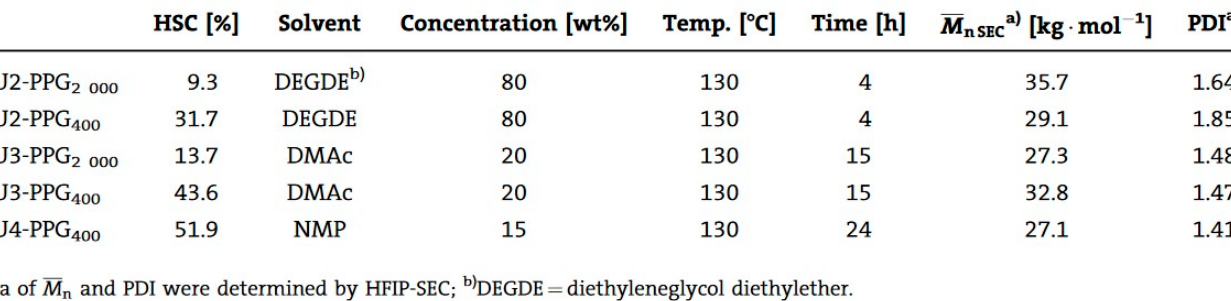
Figure 37. Table copied from reference [60]. Results of polymerizations of dicarbamates with PPGda. From reference